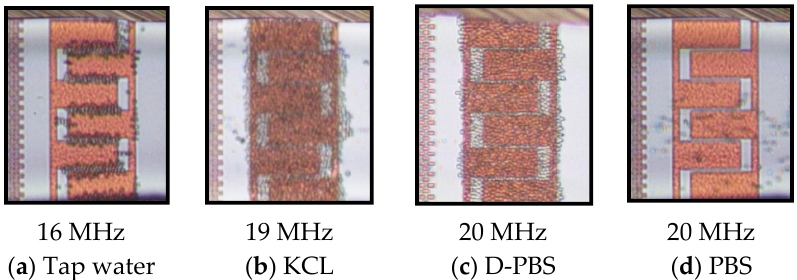
Figure 8. DEP behavior of live yeasts in different medium solutions at 20 Vpp and 1 µm s − 1 flow rate: ( a – c ) pDEP, which leads to cell trapping and; ( d ) nDEP and no cell trapping.